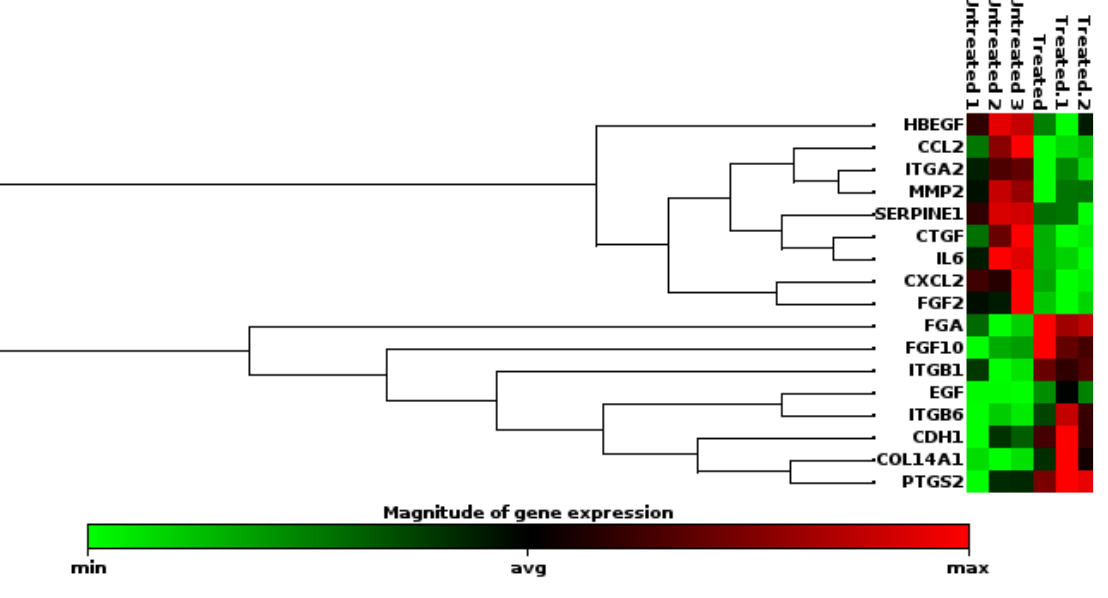
Figure 4. Clustergram of DEGs expressed in Cotyledon -AgNPs treated KMST-6 cells.